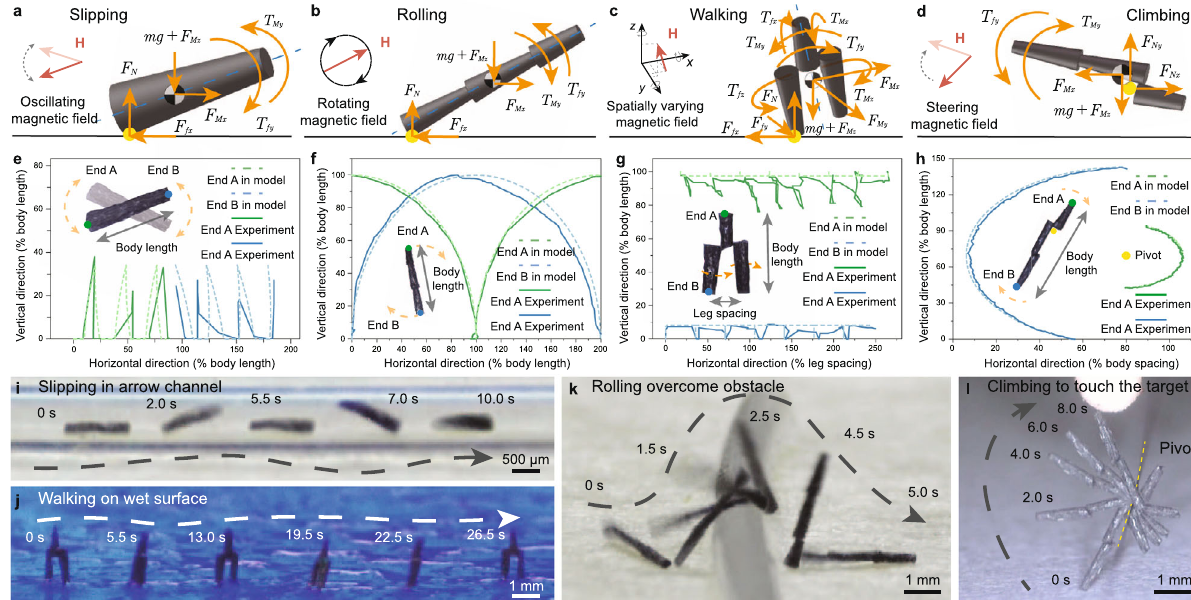
Fig. 4 Diverse morphologies and corresponding motion behaviors of mCEBOT. a Slipping of mCEBOT unit in the separated state under oscillating magnetic fi eld. b Rolling of bastinade shaped mCEBOT as a whole unit under rotating magnetic fi eld. c Walking of biped mCEBOT in the assembled state under the magnetic fi eld with spatial variation of direction. d Climbing of hoe shaped mCEBOT by anchoring on pivot under the steering magnetic fi eld. e Slipping motion trajectory and corresponding small space occupation. f Rolling motion trajectory and corresponding long step size. g Walking motion trajectory and corresponding biped locomotion characteristics. h Climbing motion trajectory and corresponding large height fl uctuation. i mCEBOT unit in separated state slips across the narrow channel. j mCEBOT units assemble into bastinade shape to roll over the obstacle. k mCEBOT units assemble into biped structure to walk with two legs on wet surface like a human. l mCEBOT units assemble into hoe shape to climb by anchoring on the